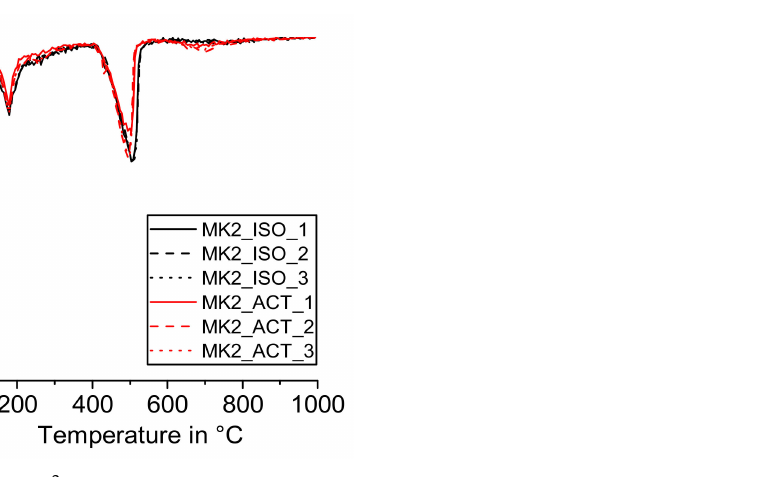
Figure 7. DTG—R 3 sample with metakaolin (MK2) dried with isopropanol (ISO) and acetone